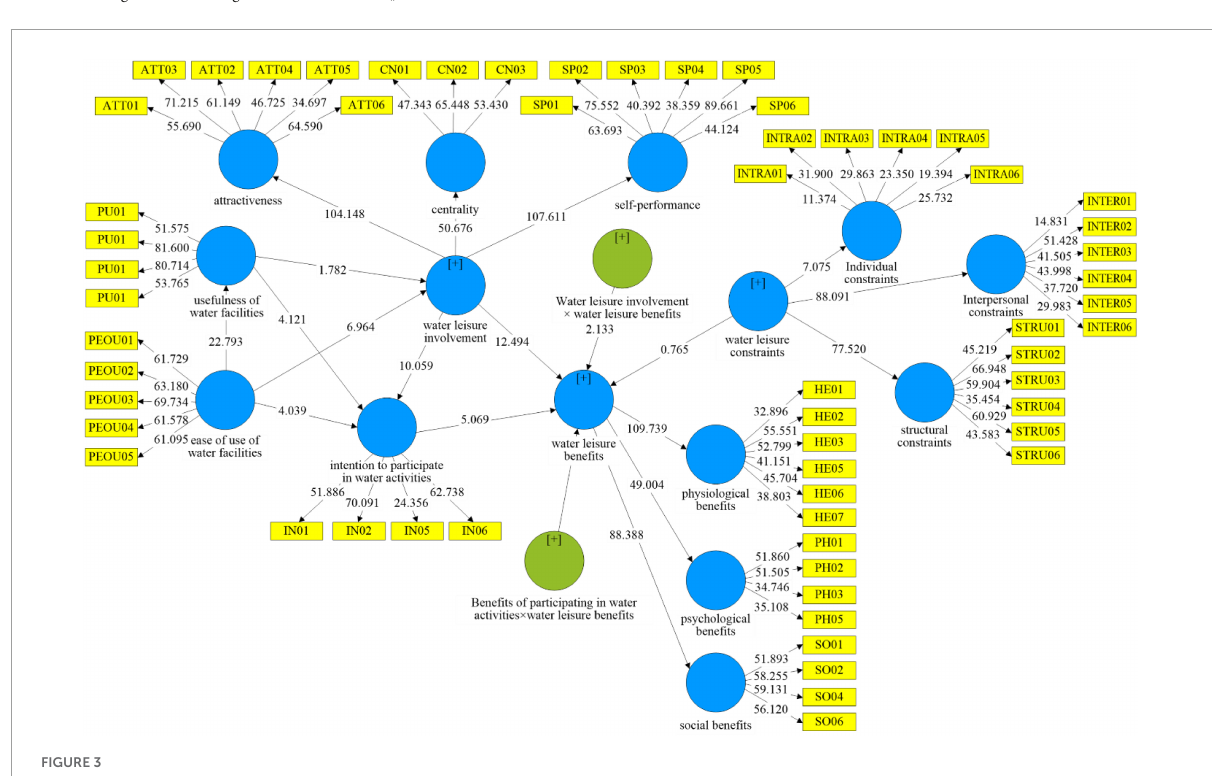
FIGURE3 Interference model analysis